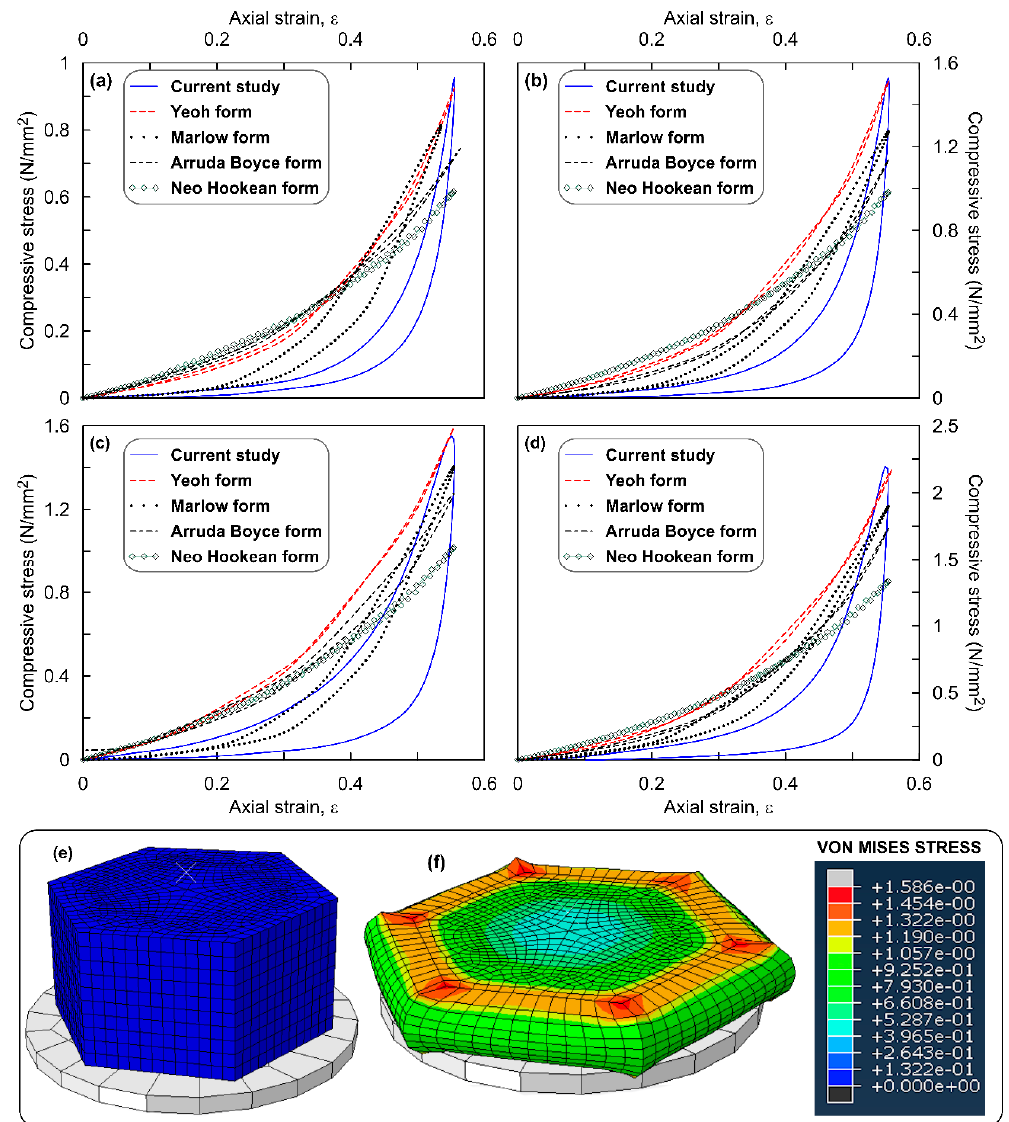
Figure 6. Stress–strain response of hexagon shaped ROPS specimens: ( a ) 0% OPS; ( b ) 5% OPS; ( c ) 10% OPS; ( d ) 20% OPS; ( e ) un-deformed model; ( f ) deformed model with stress contours at ε ≈ 50%.